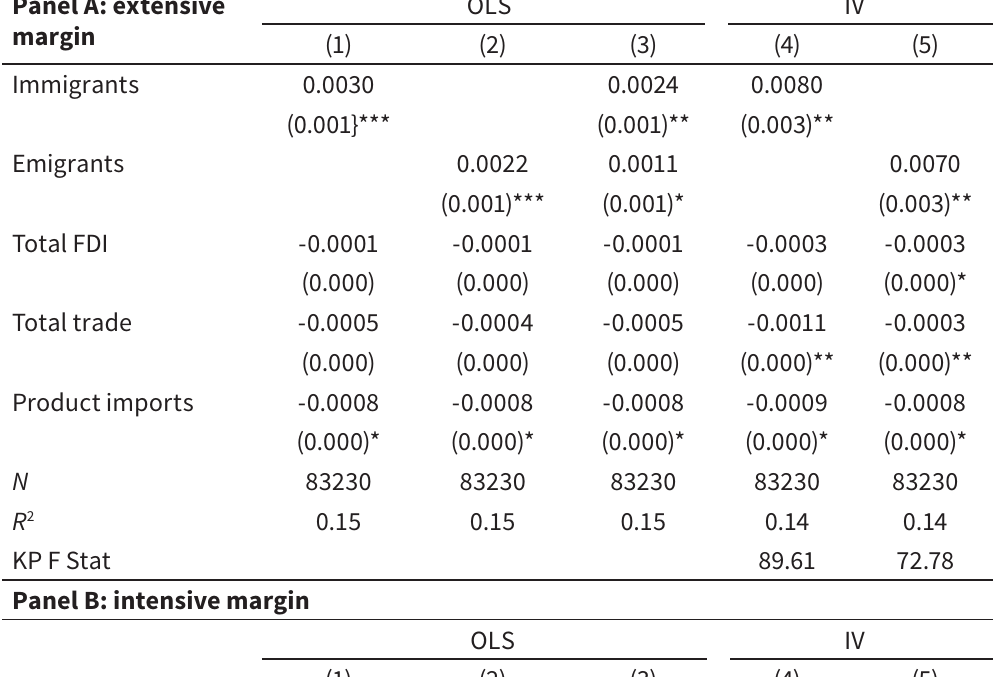
The effect of South-South migration on exports Panel A: